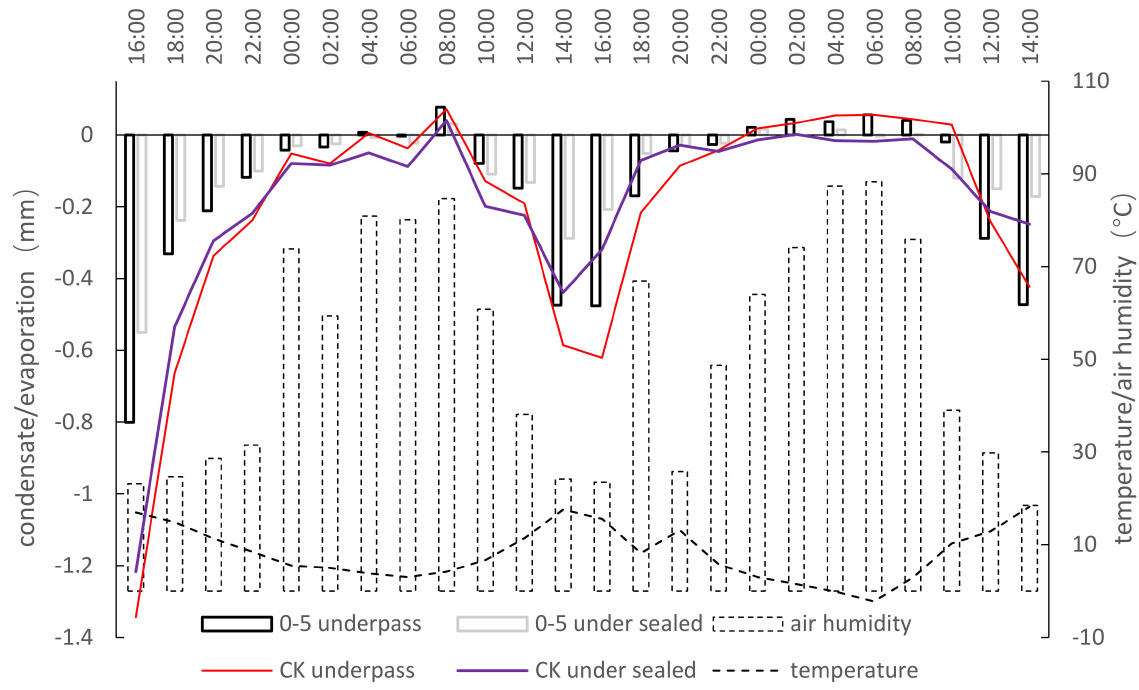
Figure 3. Condensate generation